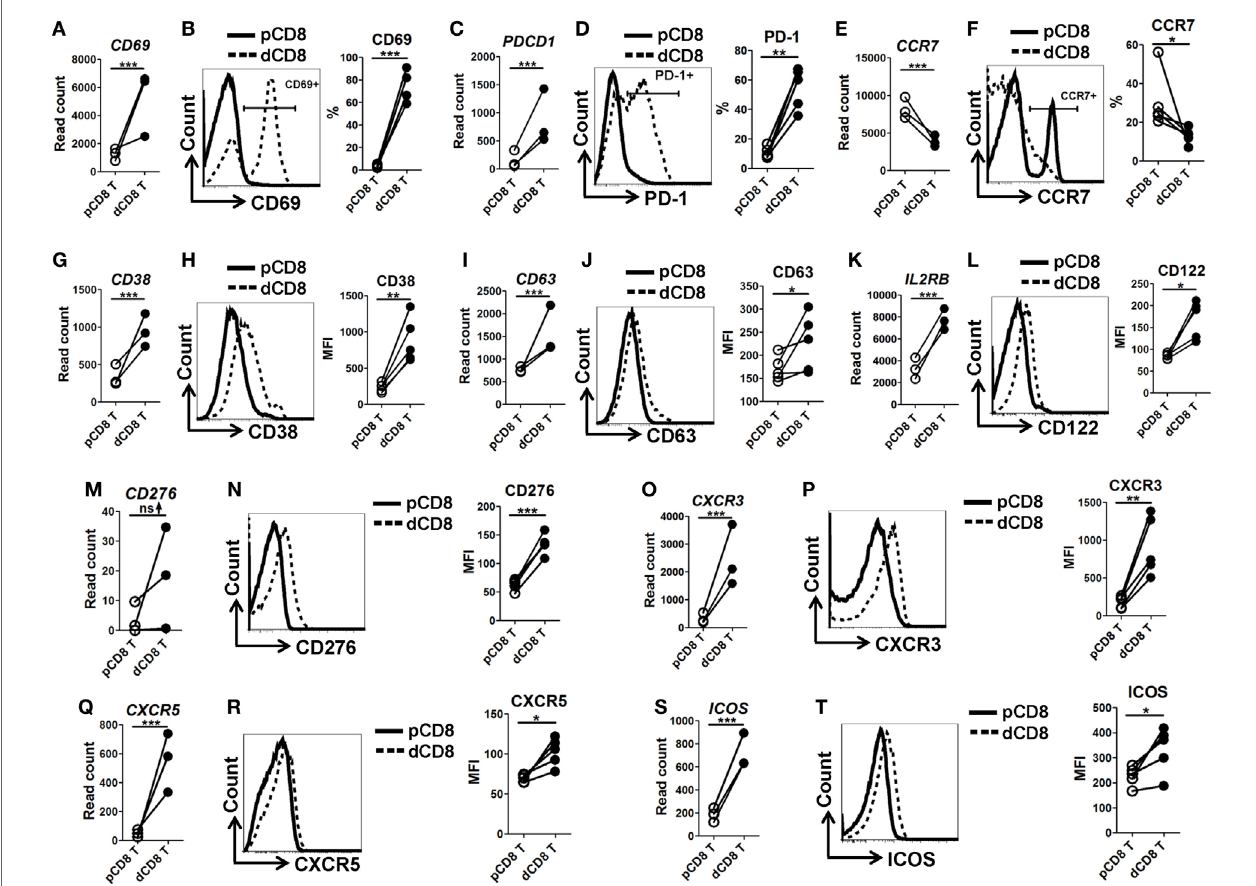
FigUre 3 | Flow cytometry validation of mRNA-Seq data. (a,c,e,g,i,K,M,O,Q,s) Comparison of the gene expression (measured as the read count) of CD69 (a) , PDCD1 [encoding PD-1, (c) ], CCR7 (e) , CD38 (g) , CD63 (i) , IL2RB [encoding CD122, (K) ], CD276 (M) , CXCR3 (O) , CXCR5 (Q) , and ICOS (s) between paired pCD8 and dCD8 T cells from mRNA-Seq data. Differential expression analysis was performed using DESeq2 algorithm (paired test). Each symbol reflects a sample and each line reflects samples from the same person ( n = 3 per group). (B,D,F,h,J,l,n,P,r,T) Representative flow cytometric histograms (left) and cumulative data (right) illustrating the comparison of molecular expression, measured as the percentage and/or geometric MFI, of indicated proteins between paired pCD8 and dCD8 T cells ( n = 5 per group). The cells are gated in CD8 + T cells and the data are representative of two independent experiments. The flow cytometric data were assessed statistically using the paired Student’s t -test (B,D,h,J,l,n,P,r,T) or Wilcoxon matched pairs test (F) . Abbreviations: pCD8 T, peripheral blood CD8 + T; dCD8 T, decidual CD8 + T; %, percentage; MFI, mean fluorescent intensity; mRNA sequencing;